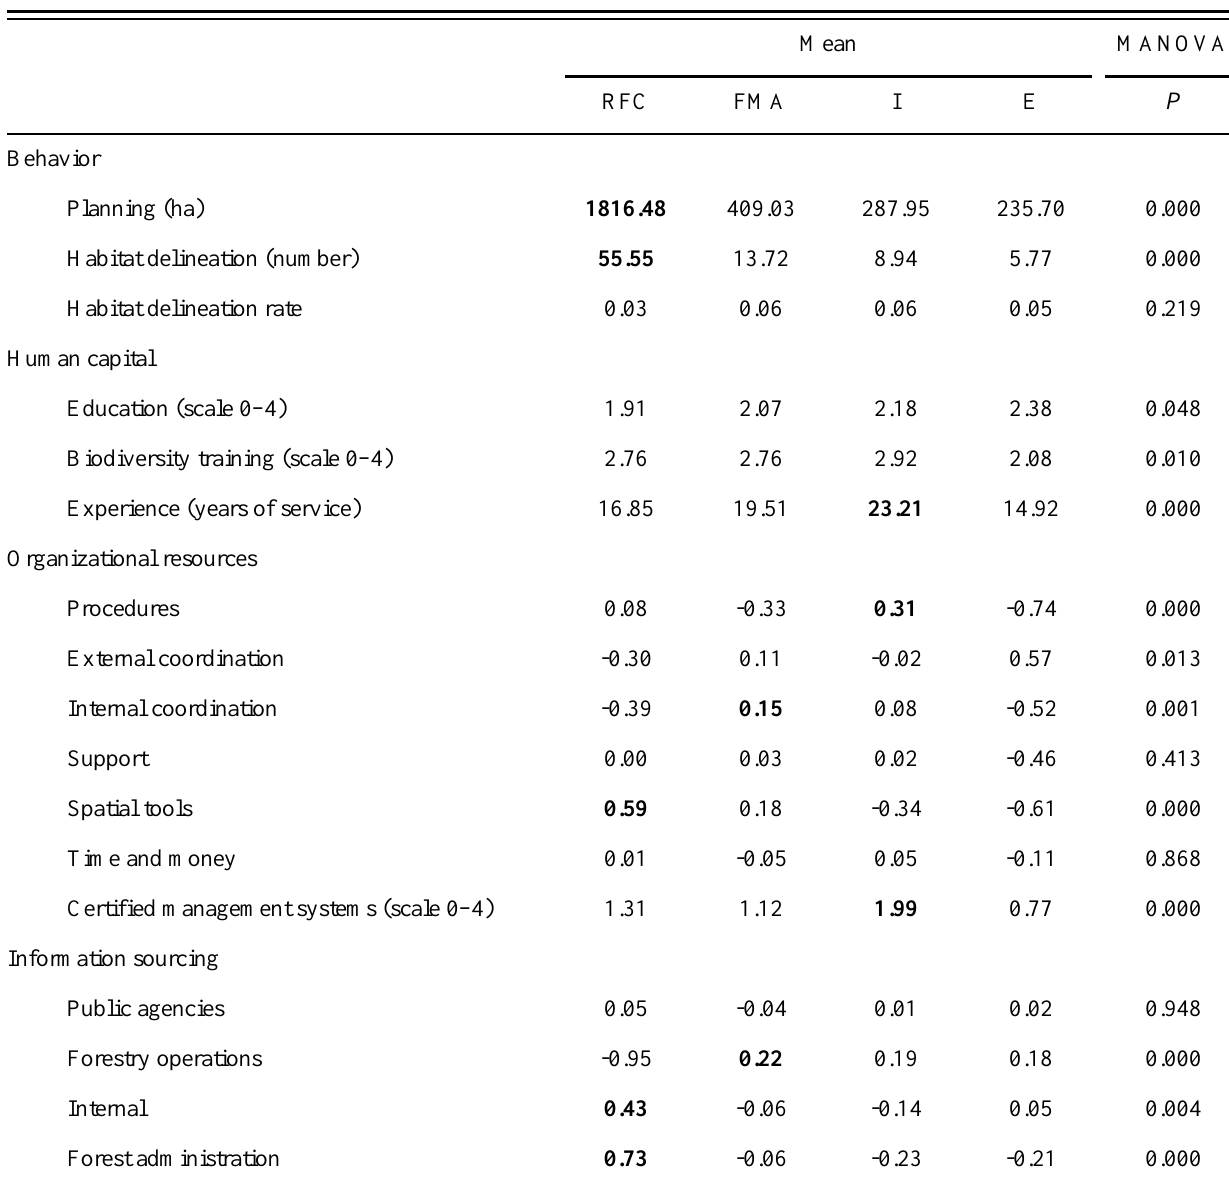
Table 3 . Analysis of variance between actor behavior and resource mobilization: mean and statistical significance of difference between groups. Values in bold are the highest means of those variables whose analysis of variance was significant at P < 0.005. RFC stands for regional forestry center ( N = 44); LFMA, for local forest management association ( N = 111); I, for industry ( N =132); and E, for entrepreneur ( N = 13). Mean MANOVA RFC FMA